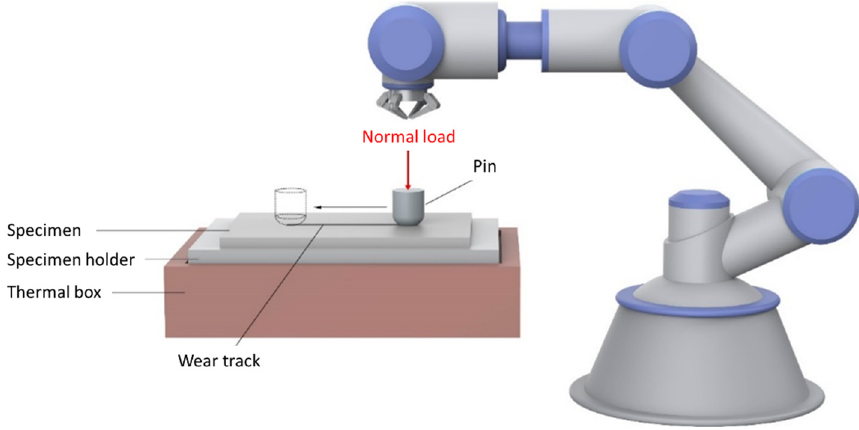
Figure 1. A schematic diagram of the friction testing equipment, Tribo-Mate [3]. Table 1. The testing matrix for water and oil-based lubricants.